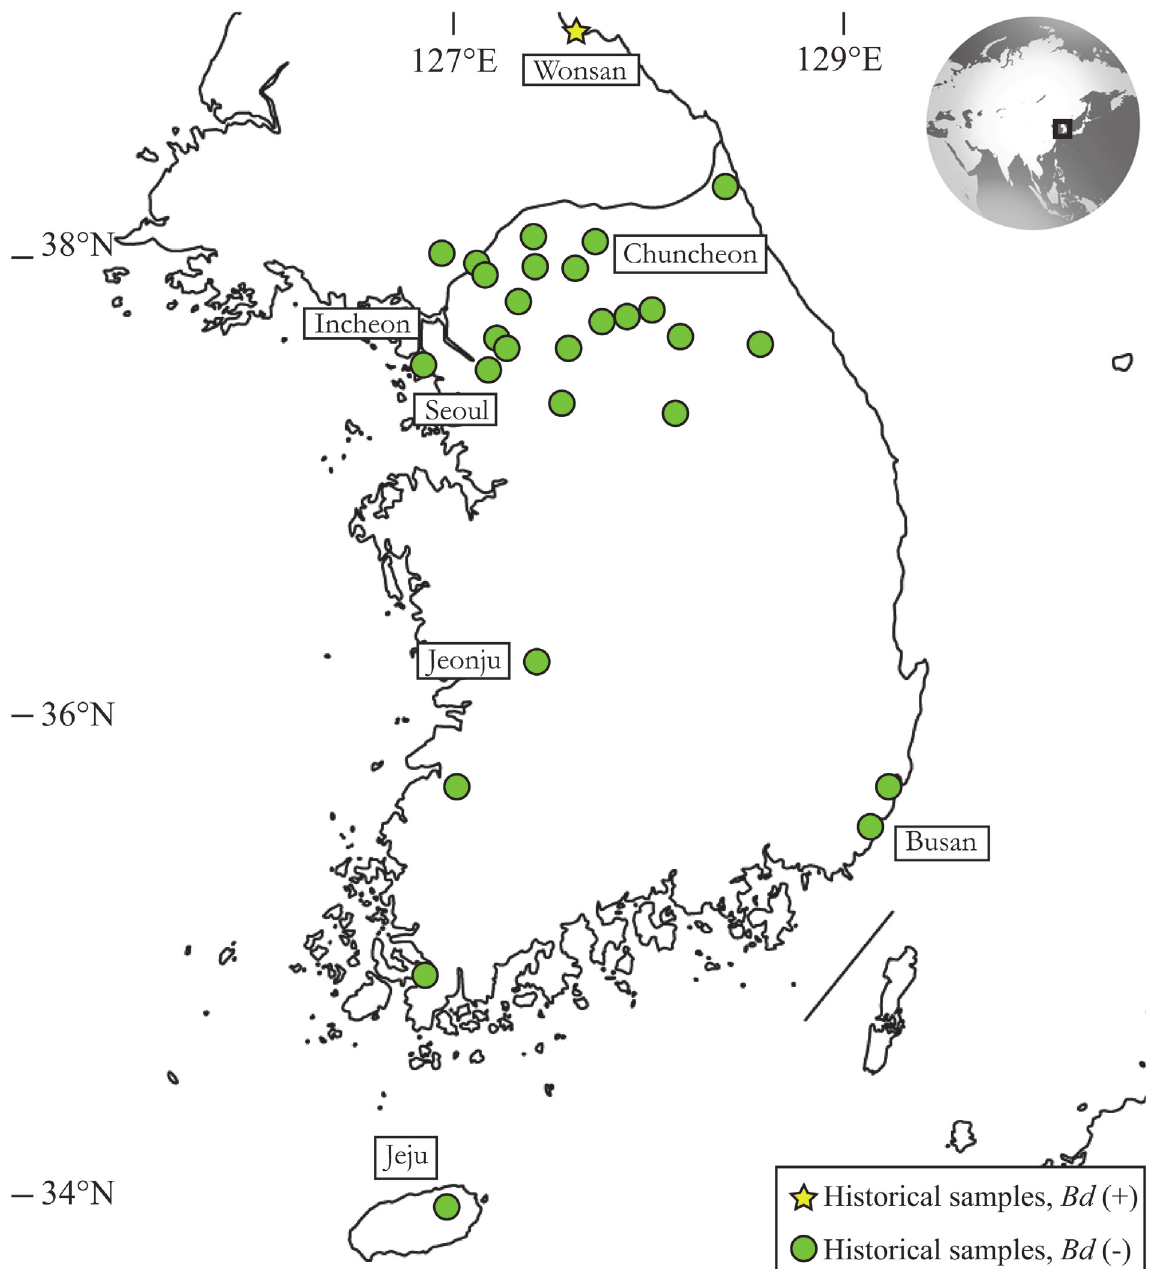
Fig 1. Sampling of historical specimens across the Korean Peninsula used in this study. Specimens were collected between 1911 and 2004. Three specimens of Rugosa emeljanovi (previously Rana or Glandirana rugosa ), collected from Wonsan, North Korea in 1911, tested qPCR positive for Batrachochytrium dendrobatidis ( Bd )